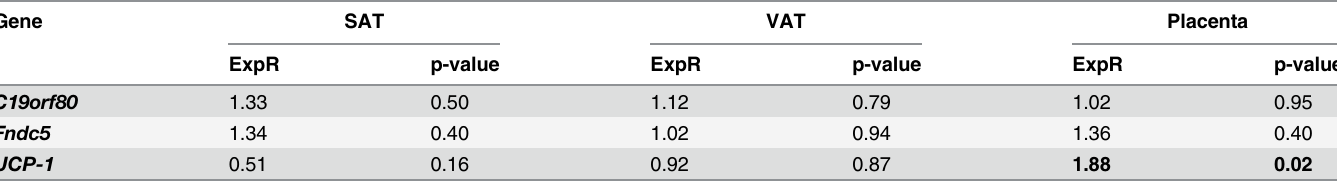
Relative gene expression of the respective gene in the healthy pregnant group =